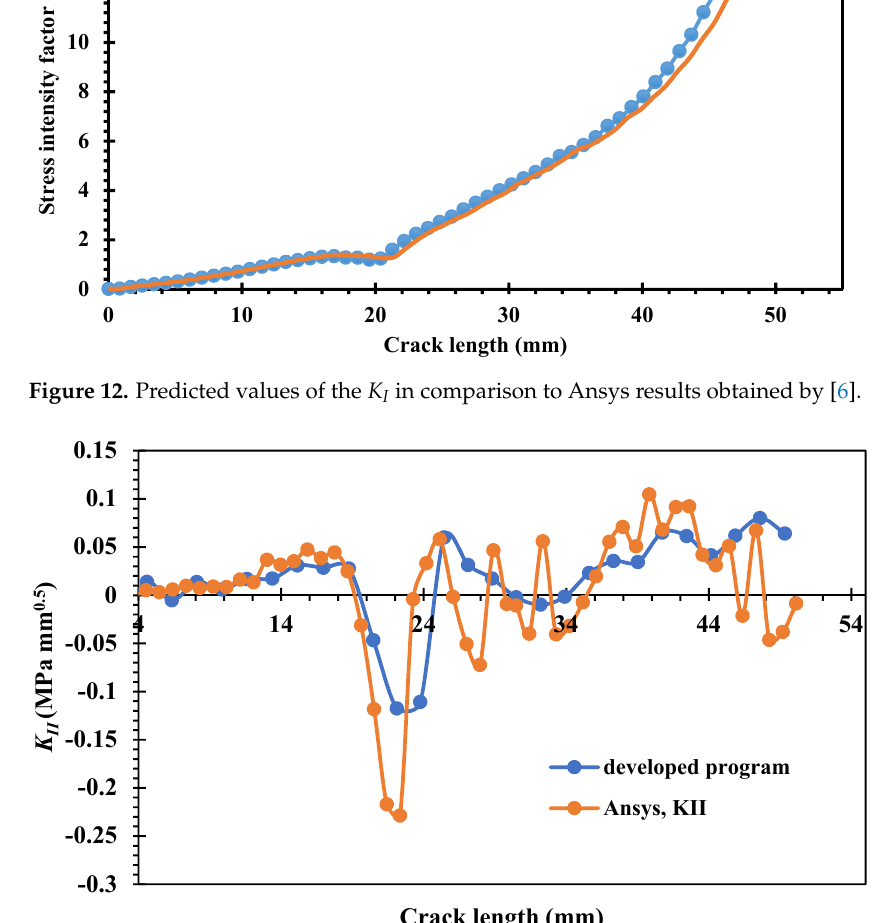
Figure 13. Predicted values of the K II in comparison to Ansys results obtained by [6].